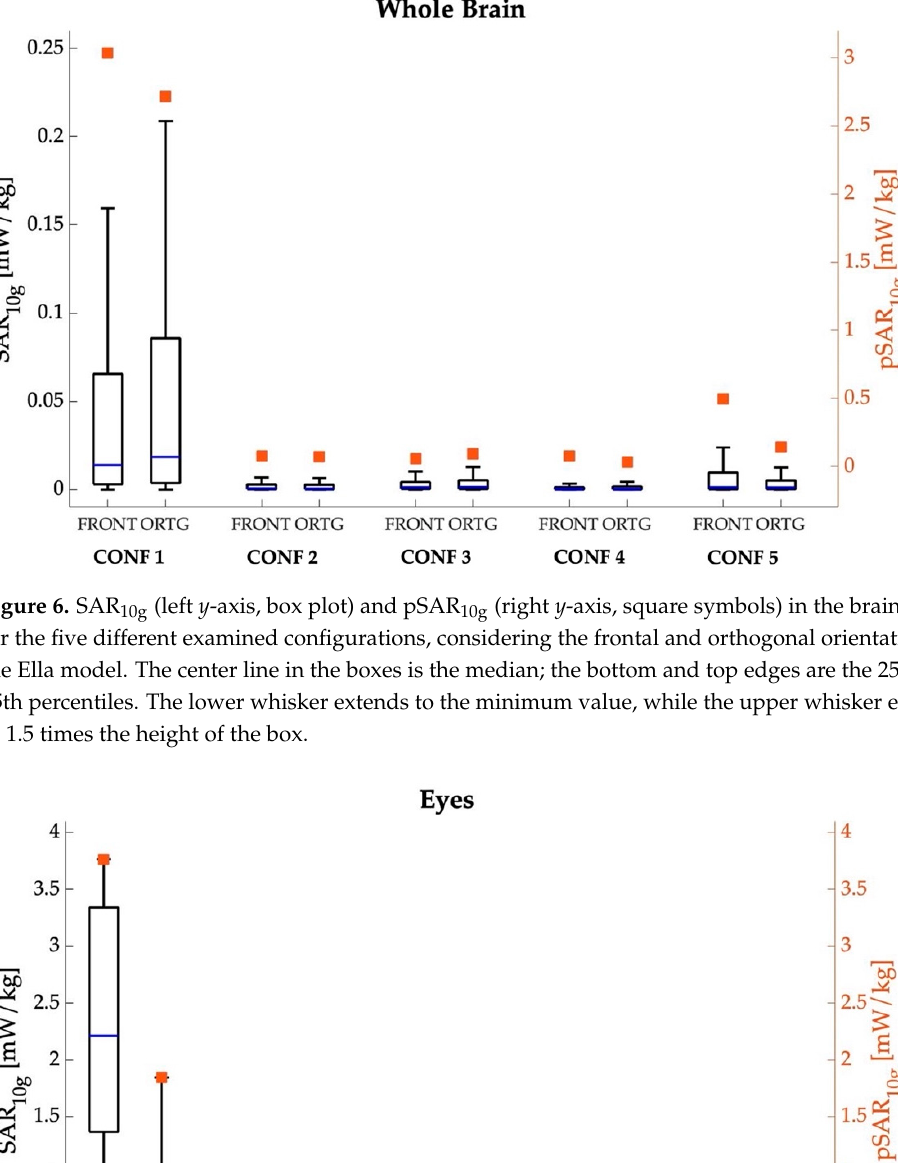
Figure 5. SAR 10g (left y -axis, box plot) and pSAR 10g (right y -axis, square symbols) in the skin tissue over the whole body for the five different examined configurations, considering the frontal and or- thogonal orientations of the Ella model. The center line in the boxes is the median; the bottom and top edges are the 25th and 75th percentiles. The lower whisker extends to the minimum value, while the upper whisker extends to 1.5 times the height of the box.